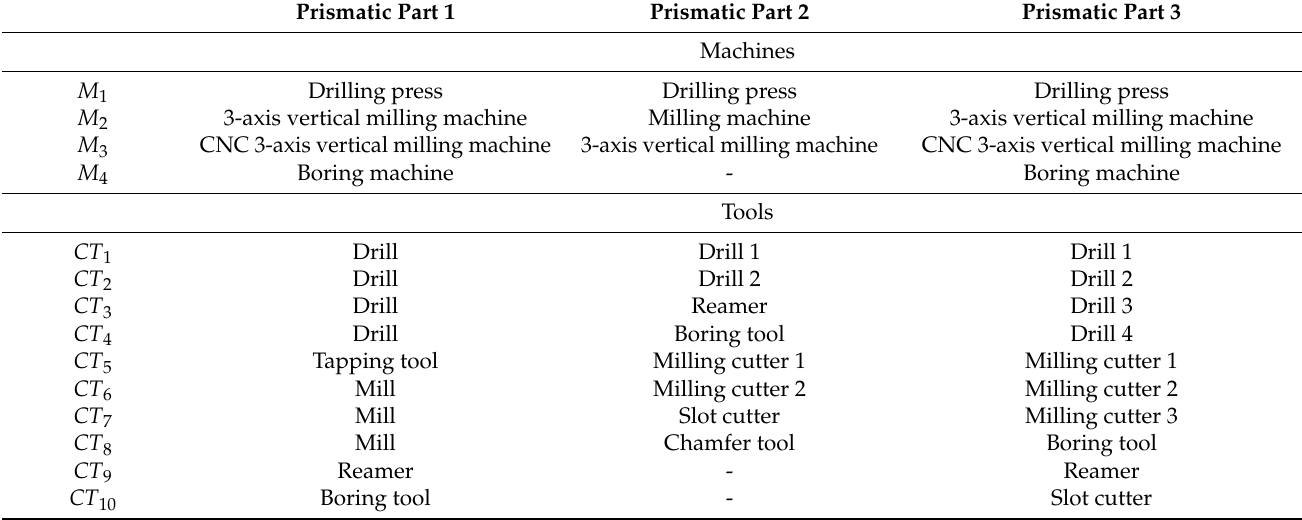
Table 6. Available machining resources for three prismatic